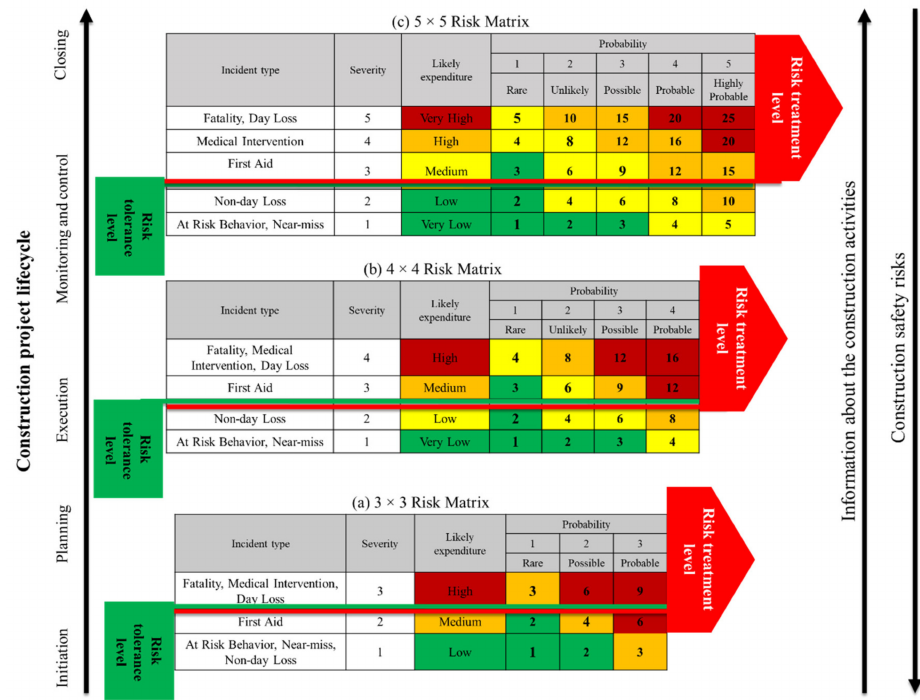
Figure 13. Application of predicted multi-class severity within different RA